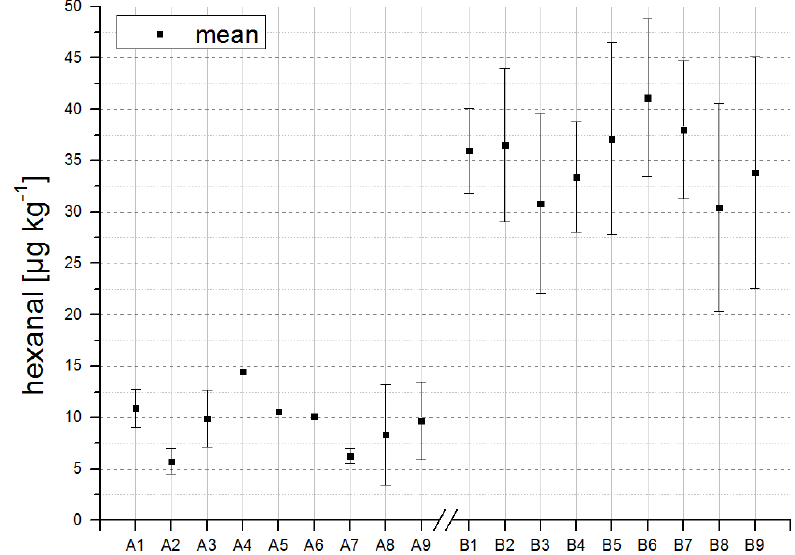
Figure 1. Overview of hexanal concentrations in formulations with antioxidants ( A ) and without antioxidants ( B ). Reconstitution of powdered formulas was performed in